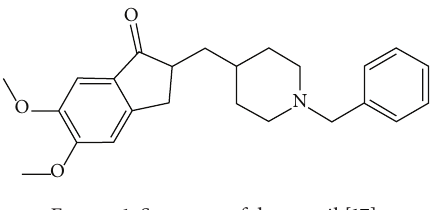
Figure 1: Structure of donepezil